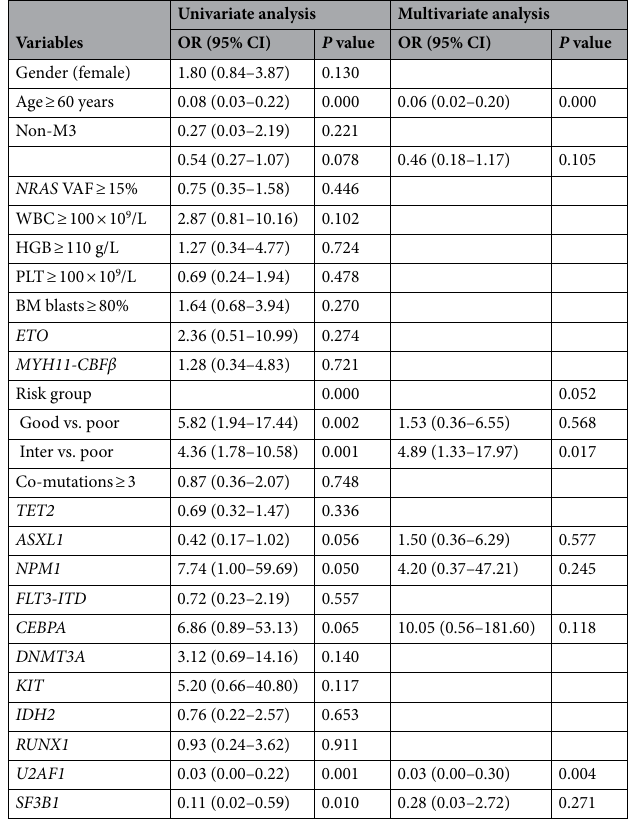
Table 2. Univariate analysis and multivariate analysis of response to induction therapy in NRAS mut AML. OR Odds ratio, VAF variant allele frequency, WBC white blood cell, HGB hemoglobin, PLT platelets, BM bone